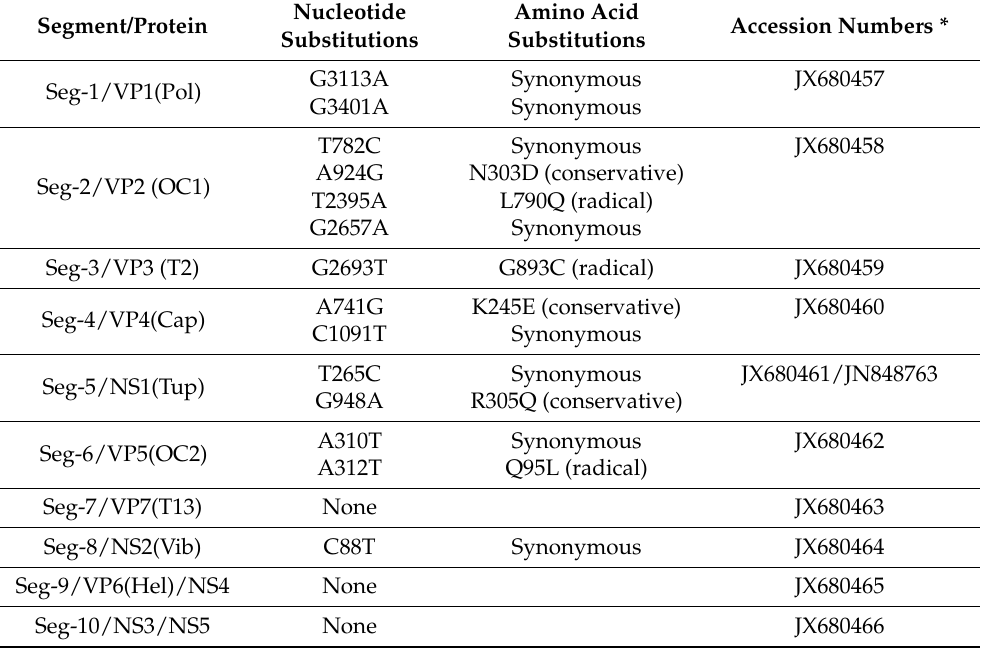
Table 3. Nucleotide and/or amino acid substitutions detected in the genome of BTV-1RG C7 as compared to the reference sequences of BTV-1RSArrrr/01. * Accession numbers of the reference strain of BTV-1RSArrrr/01 used for sequence